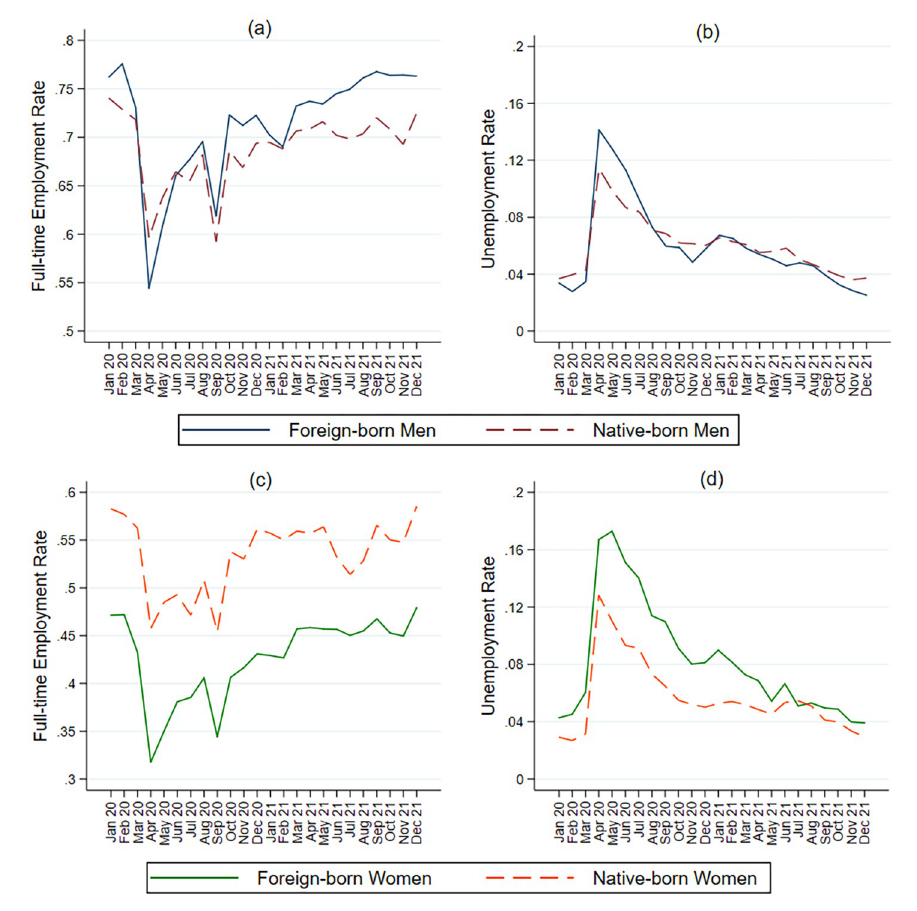
Fig 1. Employment levels of foreign-born and native-born men and women, January 2020-December 2021.